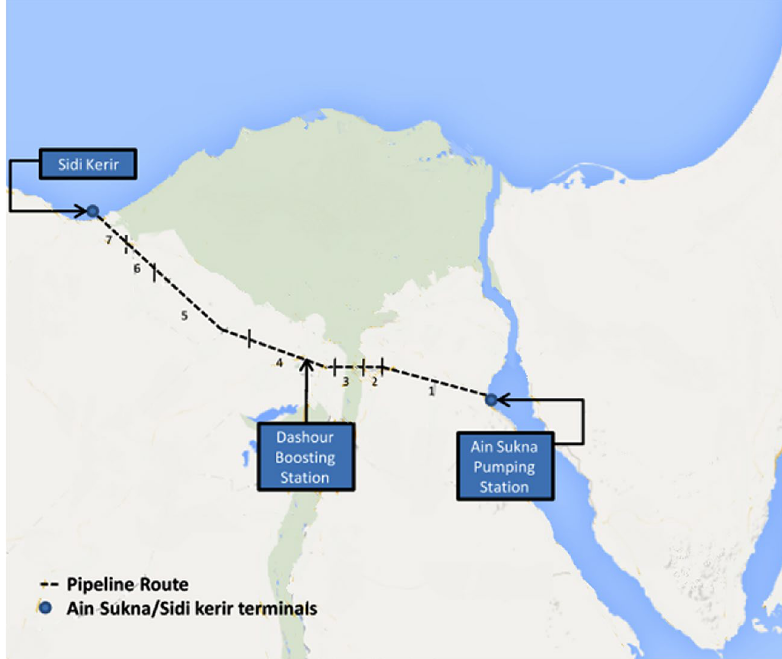
Figure 9. SUMED pipeline sections 59,60 .